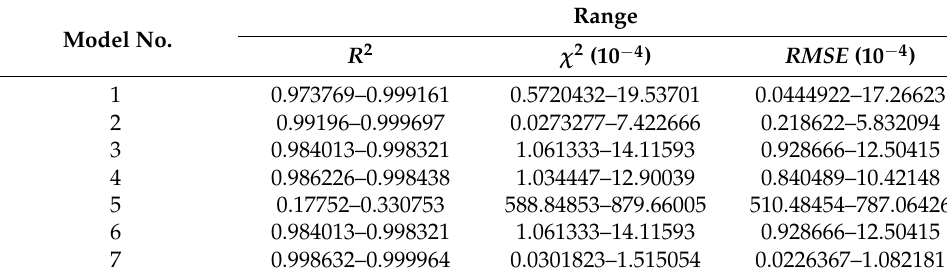
Table 5. Comparison of evaluation indicators. Model